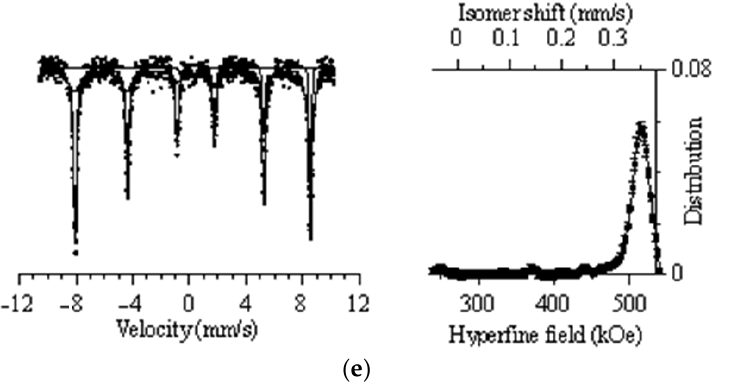
Figure 4. Mössbauer spectra of the studied nanocomposites: ( a ) Fe 2 O 3 nanoparticles; ( b ) Fe 2 O 3 @GdFeO 3 nanoparticles; ( c ) Fe 2 O 3 @NdFeO 3 nanoparticles; ( d ) CeFeO 3 nanoparticles; ( e ) YFeO 3